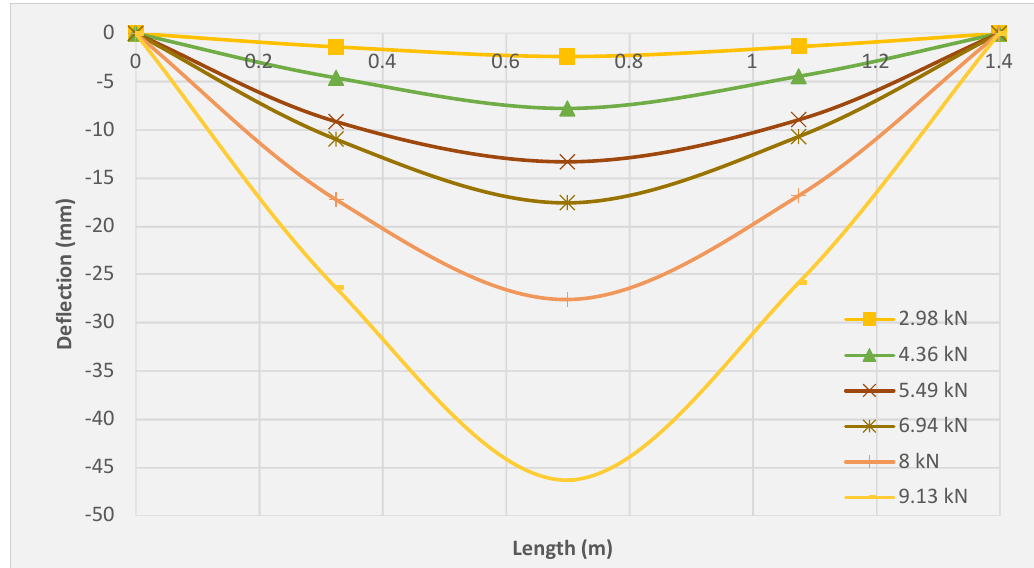
Figure 12. Deflection profile for the SRC + 1T tested slab.